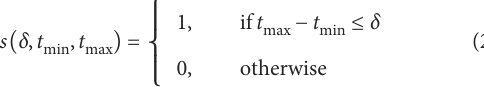
tracking the minimum and maximum iteration times ( t